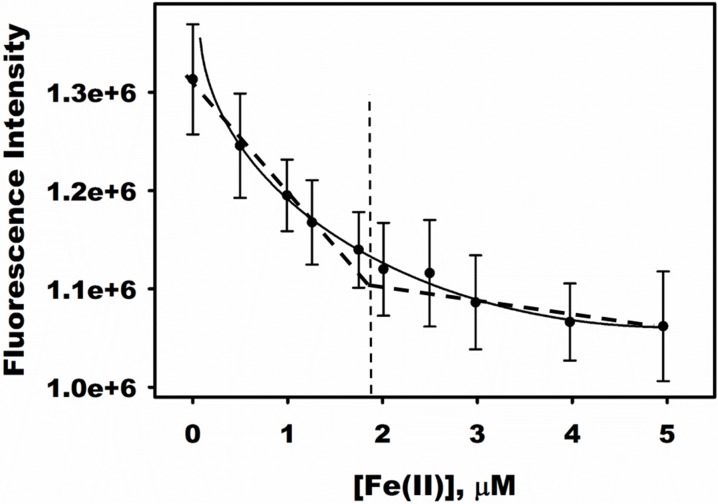
Stoichiometry of Fe(II) binding to DddW.2 μM apo-DddW (under tight-binding conditions) was titrated with increasing concentrations of Fe(NH4)2(SO4)2 and the fluorescence intensity was monitored. The titration data were analyzed by nonlinear curve fitting using Eq (3) to produce the solid line. Upon data fitting, the stoichiometric ratio of Fe(II) to DddW monomer was determined to be 1:1.